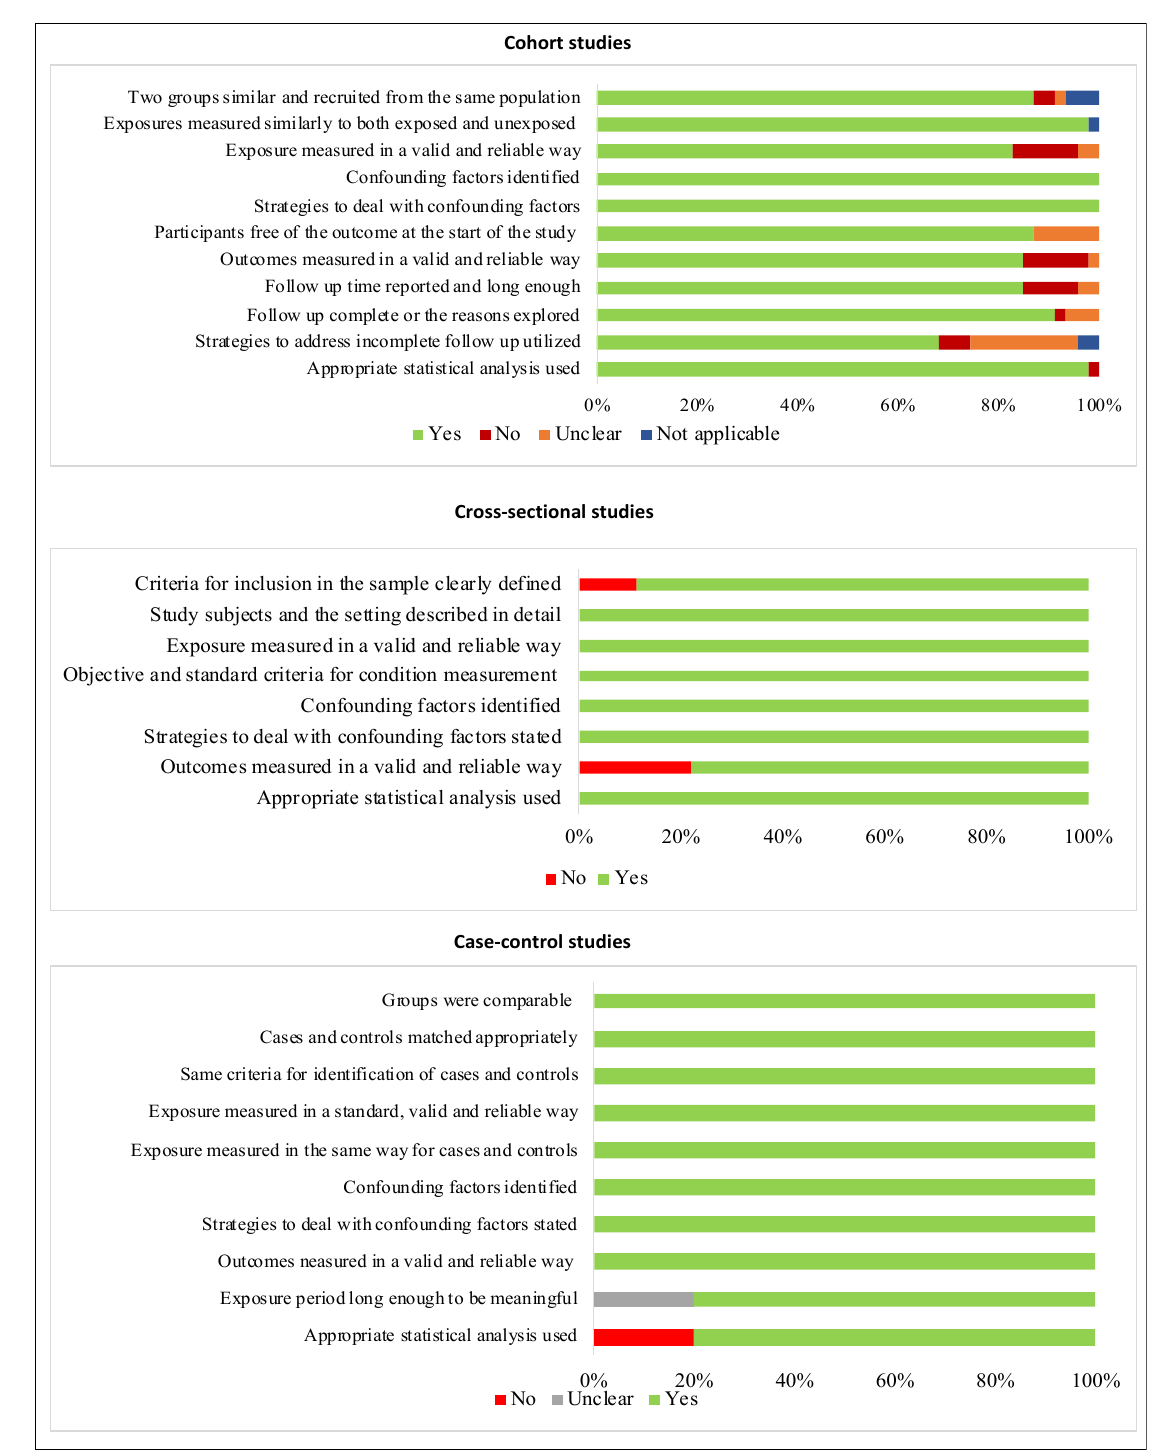
Figure 2. Risk of bias of the included articles according to study design.